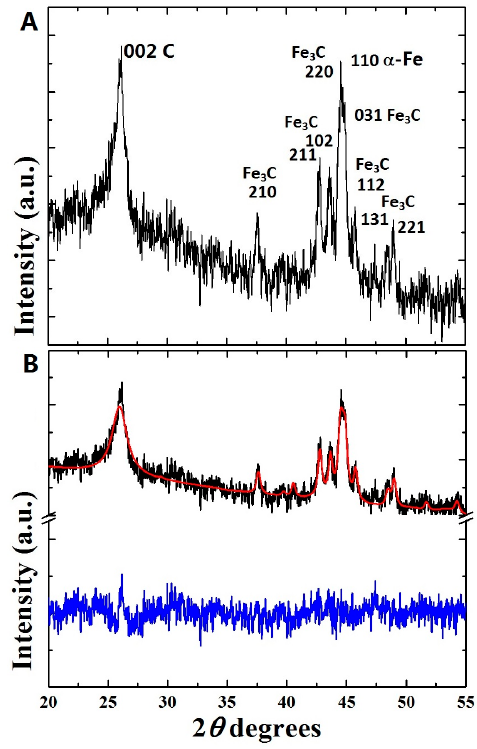
Figure 2. In ( A ) a typical X-ray diffraction (XRD) pattern of the as grown ferromagnetically filled CNTs buckypaper is shown. In ( B ) the XRD-pattern (black line) and Rietveld refinement (red line) of the as grown buckypaper is illustrated. The difference between the theoretical fit and the experimental data is represented by the blue line ( B ).